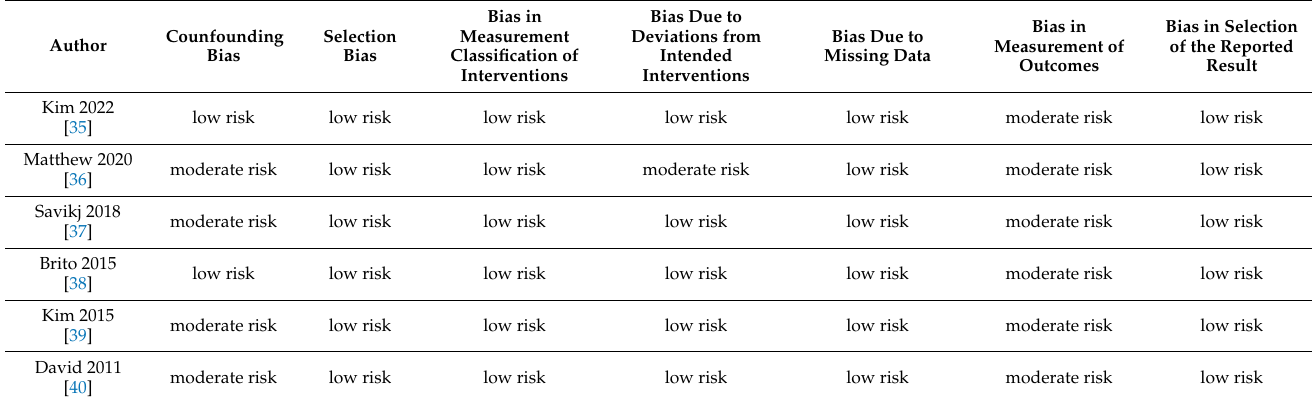
Table 2. Risk of bias assessment for non-randomized controlled